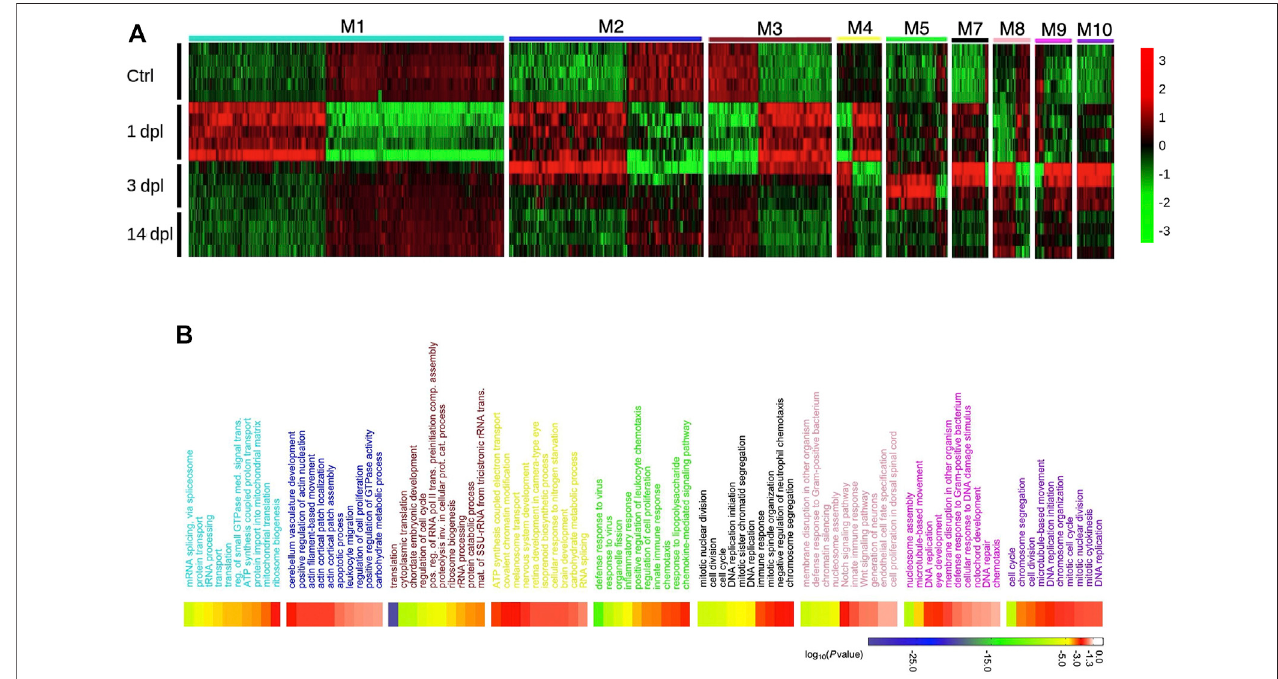
FIGURE3| Networkanalysisofzebra fi shbrainregenerationatthreestagesrevealsstage-speci fi cmodules. (A) Heatmaprepresentingrelativeexpression(z-score) of genesthat areenriched ineach module for thethree stages of theadult zebra fi sh brain regeneration. Each row represents asample,and each column shows asingle gene.Redandgreenshadesshowhighorlowrelativeexpressions,respectively. (B) DAVIDwasusedtoshowthemostsigni fi cantlyenrichedGO-BPtermsbasedonthe transcriptional changes ofeach signi fi cantmodule and their associated enrichment p -values forTop 10GO-BP terms. Theheatmap scale shows log 10 of theease p -values for the most signi fi cantly enriched GO terms. dpl: days post-lesion, ctrl: control.